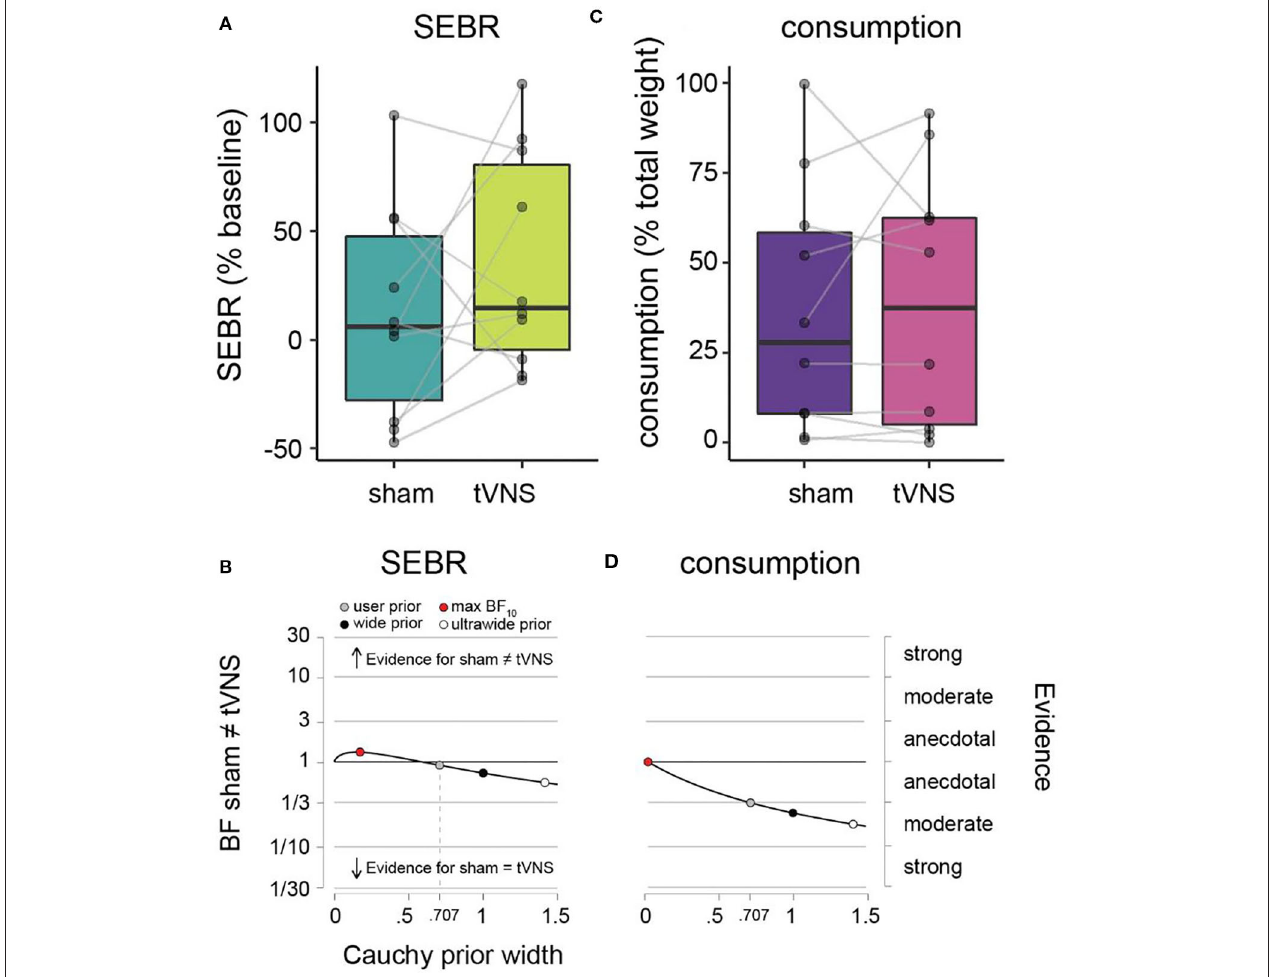
FIGURE 3 | SEBR and ad libitum consumption during sham vs. tVNS. (A) SEBR (relative to baseline) under sham (dark green) vs. tVNS (light green). (B) Robustness checks for effect of sham vs. tNVS on SEBR. (C) Ad libitum consumption (relative to total weight) under sham (purple) vs. tVNS (pink). (D) Robustness checks for effect of sham vs. tVNS on consumption. Details as in Figure 2